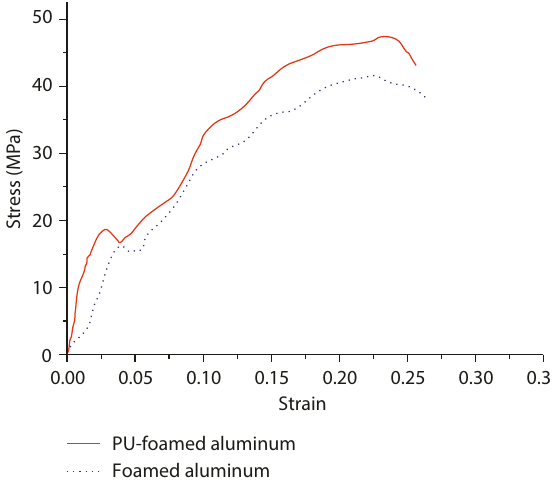
Figure 21: Stress-strain curves for the polyurethane-foamed alu- minum and the foamed